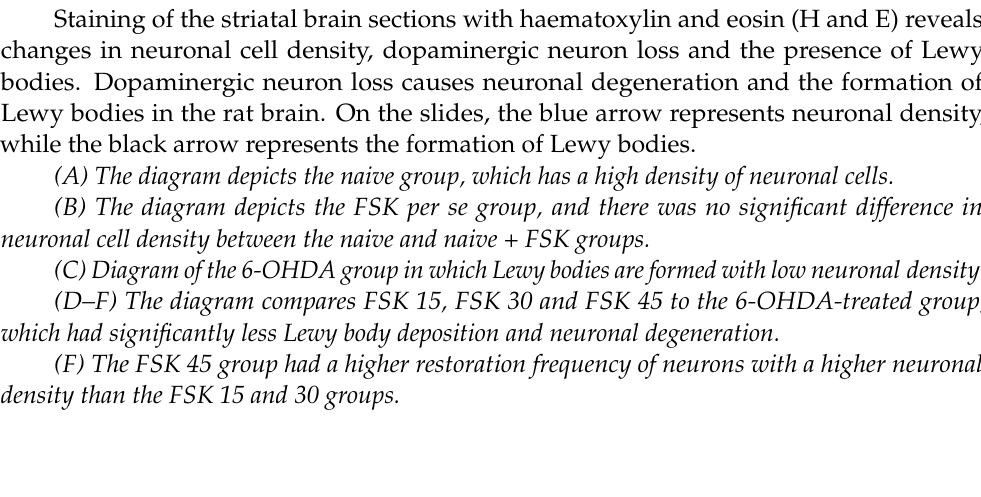
Figure 11. (a – d) FSK restored neurotransmitters in the experimental model of PD. Data provided as mean ± SD (n = 6) followed by ANOVA (one-way) with post-hoc Tukey’s test. * 6-OHDA ( p < 0.01) compared with naive and naive + FSK; # FSK15, FSK30, FSK45 (p < 0.01) compared with 6-OHDA ; #@ FSK45 (p < 0.01) compared with FSK30, FSK15 .